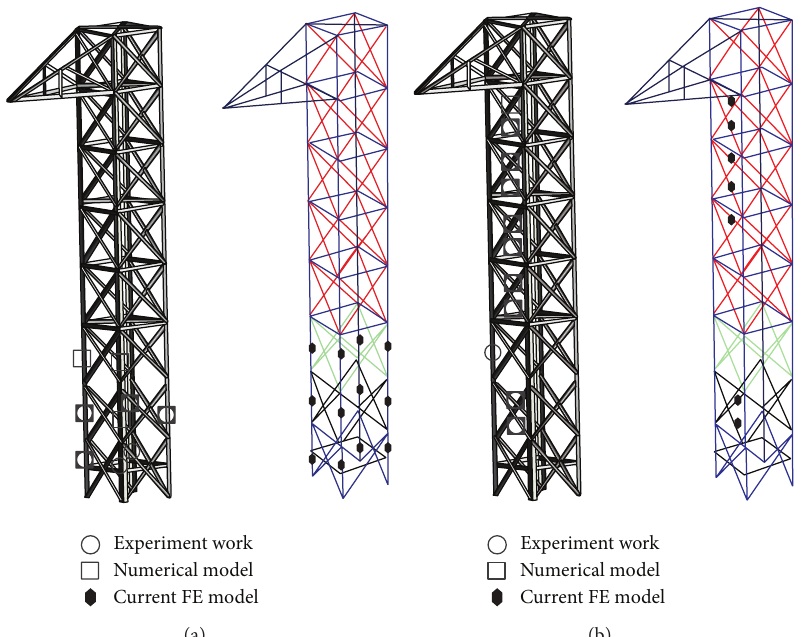
Figure 12: Members failing in Lee and McClure [19] experimental results and numerical solution and the current FE simulations (a) bending case, (b) flexure-torsion case.